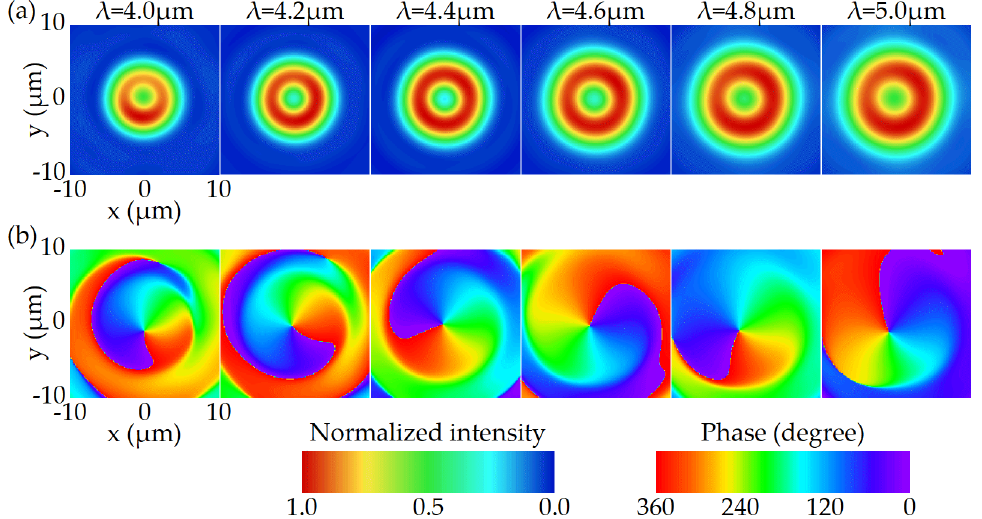
Figure 7. The simulated electric field distribution for the FVBG with positive dispersion on the focal plane between 4.0 and 5.0 μ m. ( a ) Normalized intensity. ( b ) Phase.